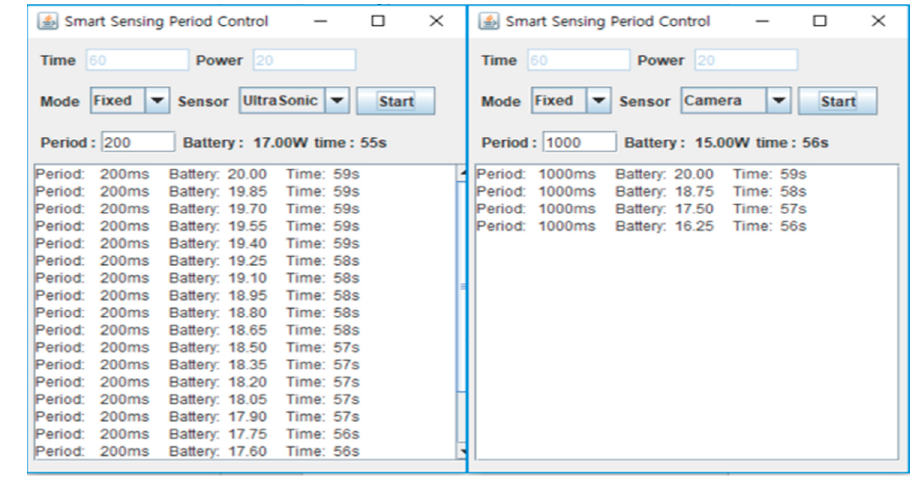
Figure 8. Screenshots of fixed period.